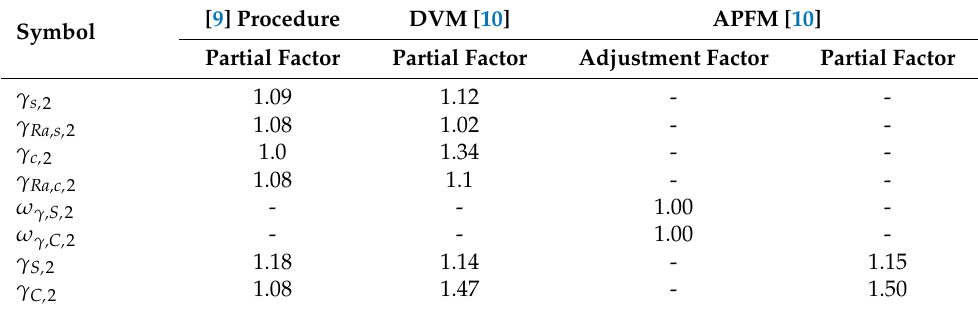
Table 10. Partial factors for resistance variables used in the second stage of the